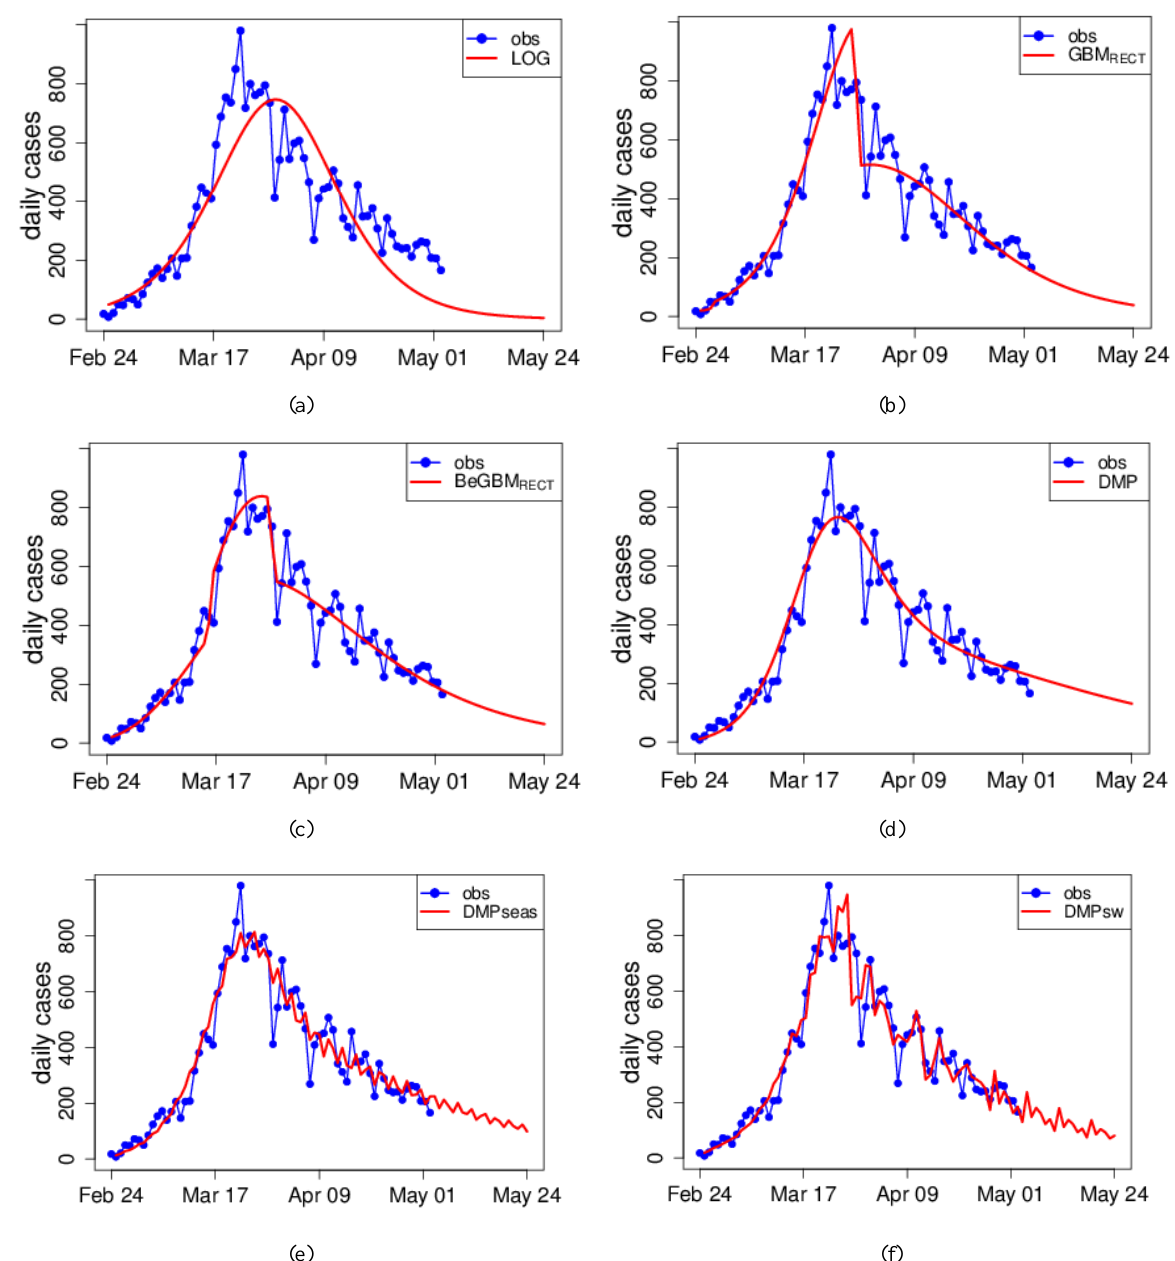
Figure 9. Emilia–Romagna. Observed and fitted values with the alternative models. (a) Logistic (LOG); (b) GBM with rectangular shock (GBM 𝑹𝑬𝑪𝑻 ); (c) Bemmaor GBM with rectangular shock (BeGBM 𝑹𝑬𝑪𝑻 ); (d) Dynamic market potential (DMP); (e) Dynamic market potential+seasonal effect (DMPseas); (f) Dynamic market potential+swabs